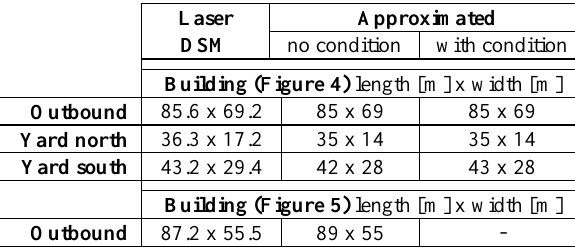
Table 1: The sizes of the approximated buildings from HSI image with spatial resolution of 4 m, compared to the sizes